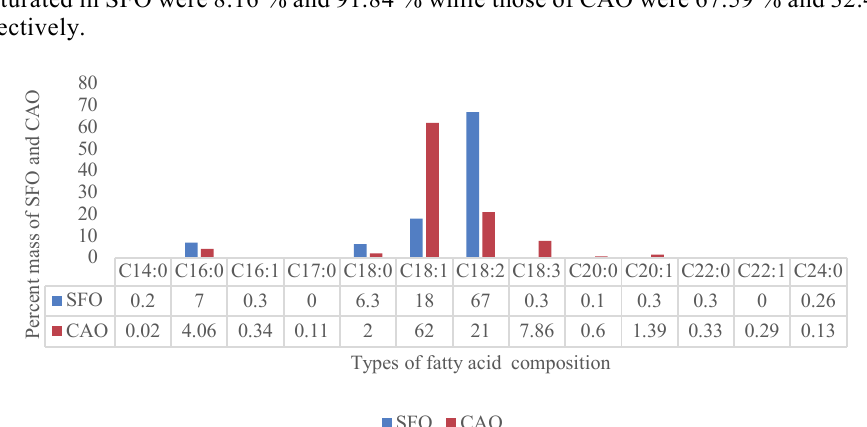
Fig. 4. Fatty acid content of SFO and